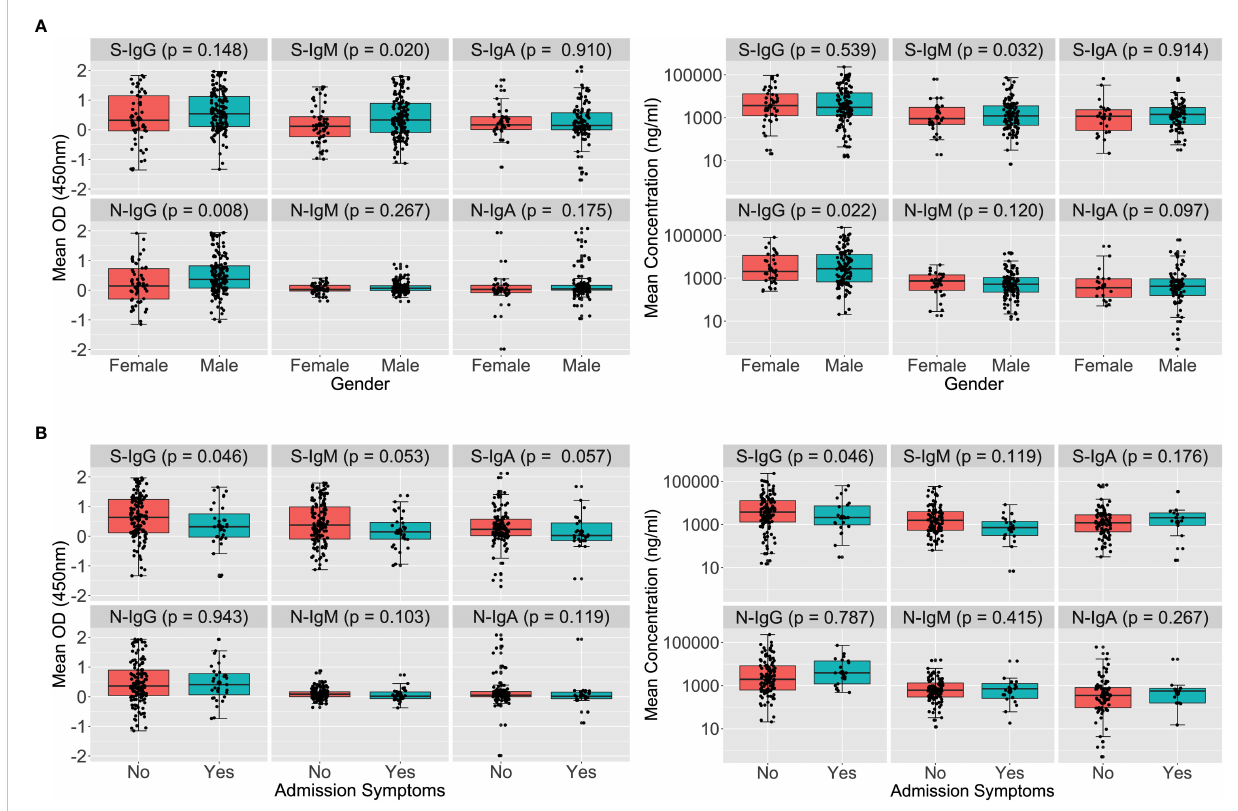
FIGURE 1 Early Spike and Nucleoprotein-directed antibodies by gender and symptoms. Figure 1 illustrates SARS-CoV-2-speci fi c antibody responses throughout the fi rst month of infection using the Wilcoxon rank sum test. The optical densities and concentrations (ng/ml) of Spike- and Nucleoprotein-directed IgG, IgM, and IgA antibodies are compared, strati fi ed by gender (A) and symptoms (B) . P-values less than or equal to 0.05 were regarded as statistically signi fi